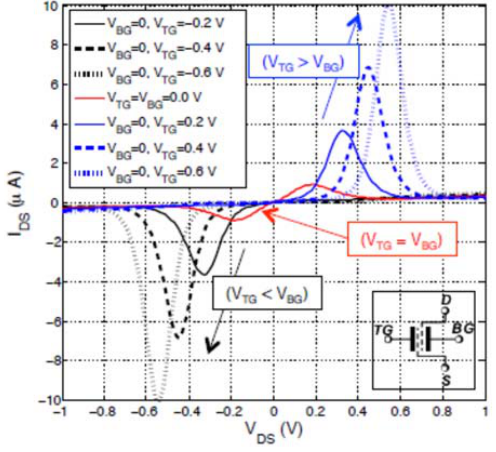
Figure 13. I ‐ V characteristic of a SymFET.